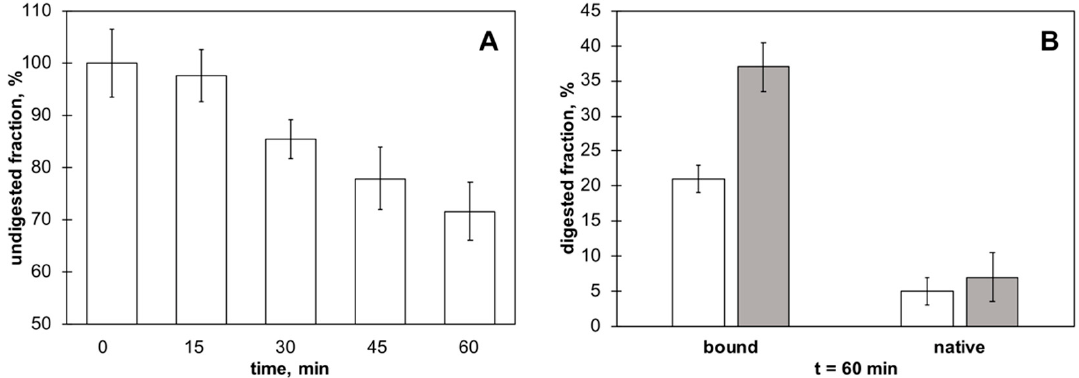
Figure 6. The adsorbed γ C’s sensitivity to trypsin and its constituent subunits. ( A ) A relative amount of γ C remained bound to the NPs over time; ( B ) the digested fraction of 30 kDa (white bars) and of 17 kDa (gray bars) subunits of γ C bound to NPs or alone after 60 min of incubation with trypsin.